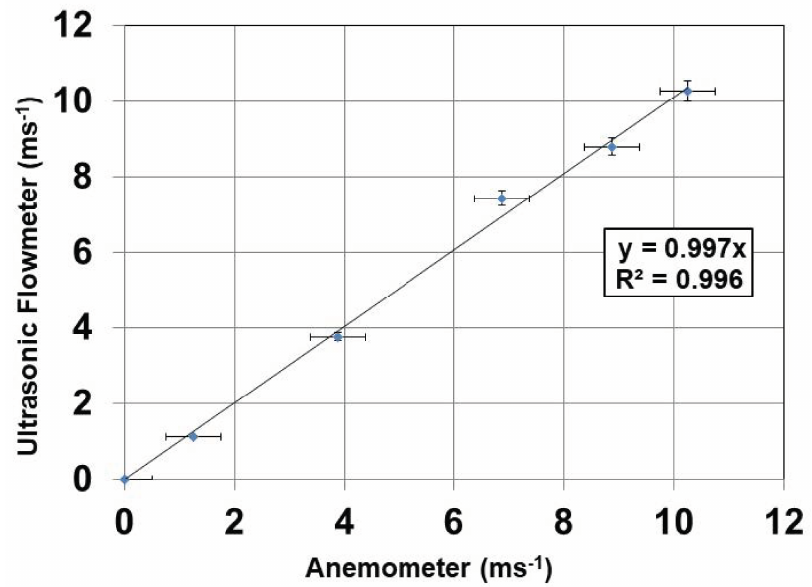
Figure 9. Volumetric flow measured in the 45 ◦ angled ultrasonic flowmeter compared to that measured in an Amprobe TMA10A anemometer. Pre-installation calibration test in air.